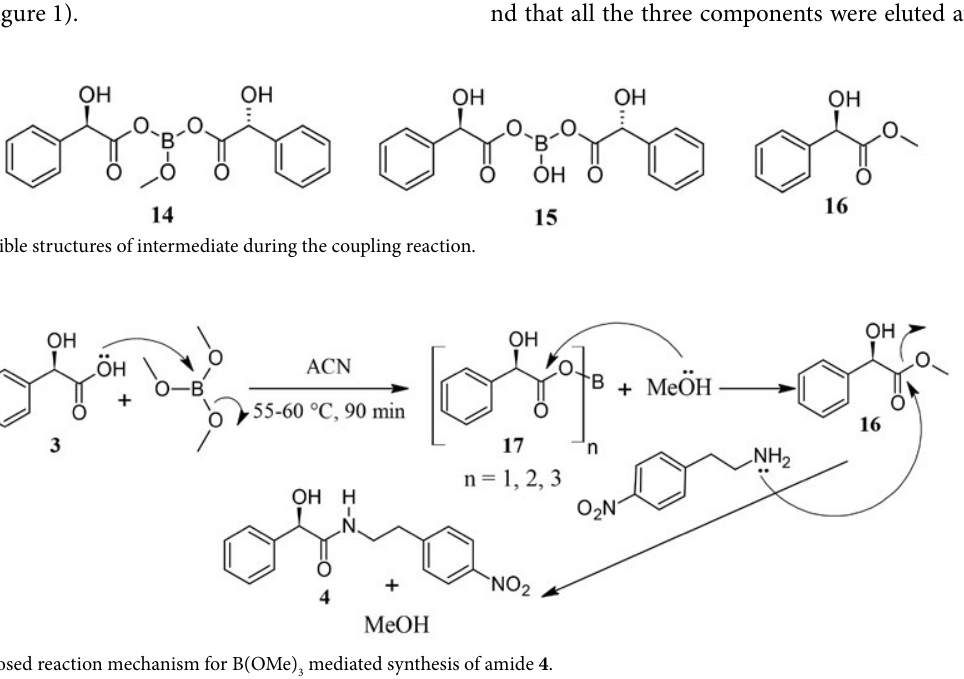
Figure 2. Proposed reaction mechanism for B(OMe)